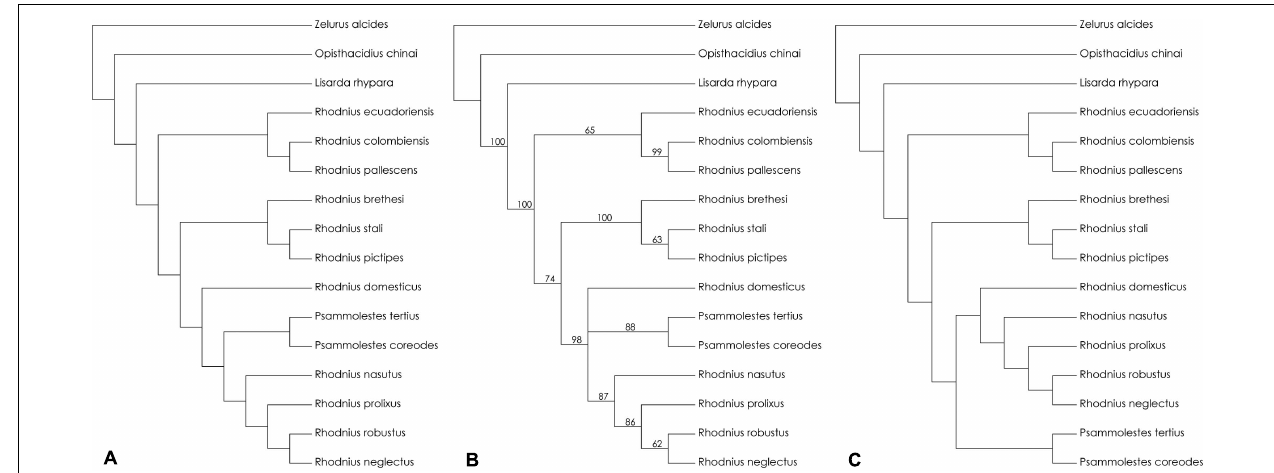
FIGURE 1 | The topology of the retained trees in the parsimony analysis combining 16S + 28S + wingless sequences retained five trees with CI = 0.838, –ln L ranging from 6101.613 to 6110.204, and AIC from 12245.226 to 12262.408 (see Table 1 ). (A) the topology with the best scores for the test for significance of likelihood-score differences—Kishino-Hasegawa test (KH). (B) bootstrap support values employing a heuristic search with 1,000 bootstrap replicates using 100 random stepwise addition (tree-bisection-reconnection, TBR). We defined values for bootstrap support > 90% as strongly supported, 90–70% as well-supported/moderate support, and < 70% as weakly supported. (C) the topology showing the alternative position of the genus Psammolestes . It was used PAUP 4.0 in the phylogenetic analysis to derive trees based on parsimony.